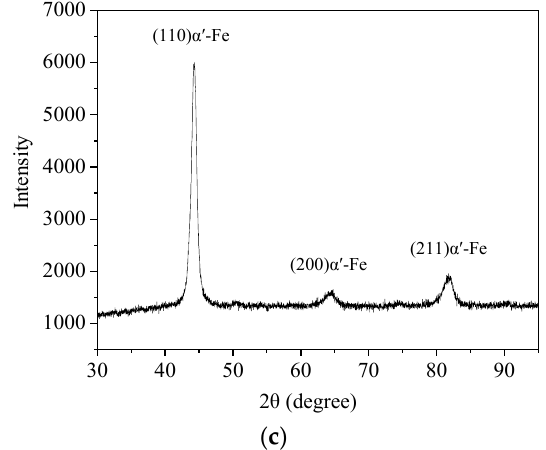
Figure 7. ( a ) Martensite phase distribution cloud atlas after carburizing and quenching; ( b ) simulation value of surface martensitic phase content of surface; and ( c ) XRD diffraction diagram of the carburized layer surface.